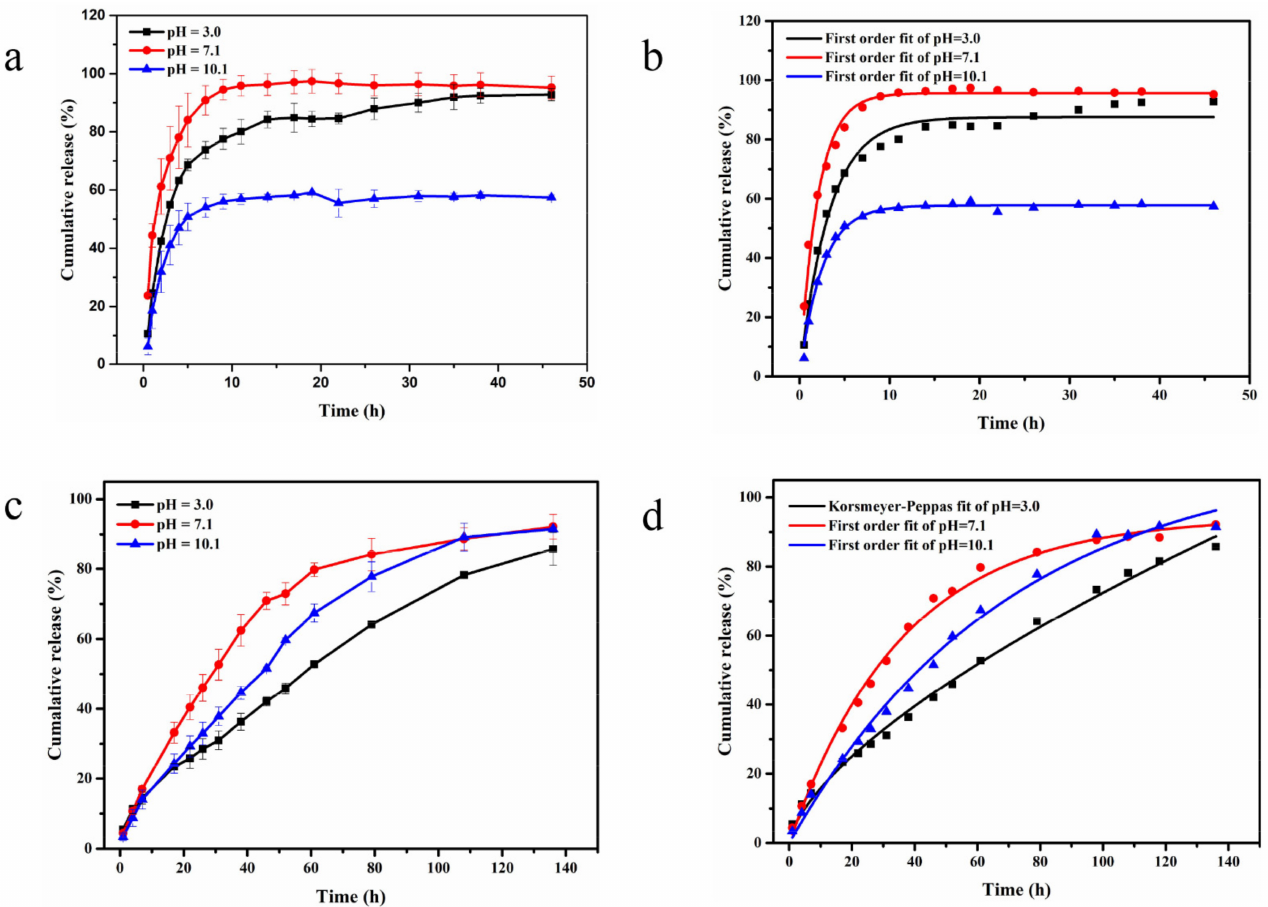
Figure 7. The curves of AZOX release from AZOX@Dini@NH 2 -Al-MIL-101 ( a ) and fitting plots using first-order equation at different pH values of 3.0, 7.1, and 10.1 ( b ); the curves of Dini release from AZOX@Dini@NH 2 -Al-MIL-101 ( c ) and fitting plots using first-order equation at different pH values of 7.1, 10.1, and Korsmeyer–Peppas model at 10.1 ( d ). Error bars correspond to standard errors of triplicate